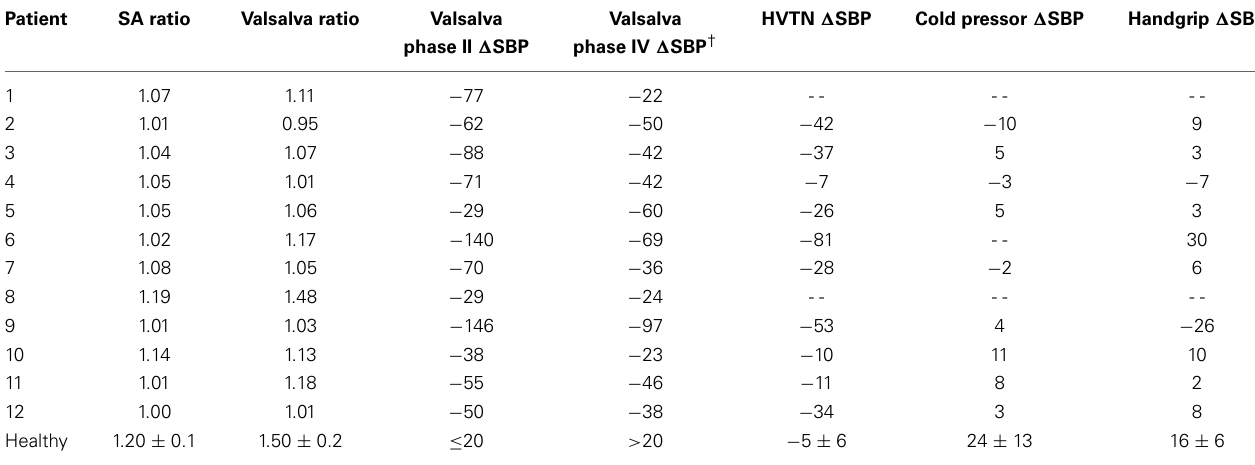
Table 3 | Autonomic function tests.